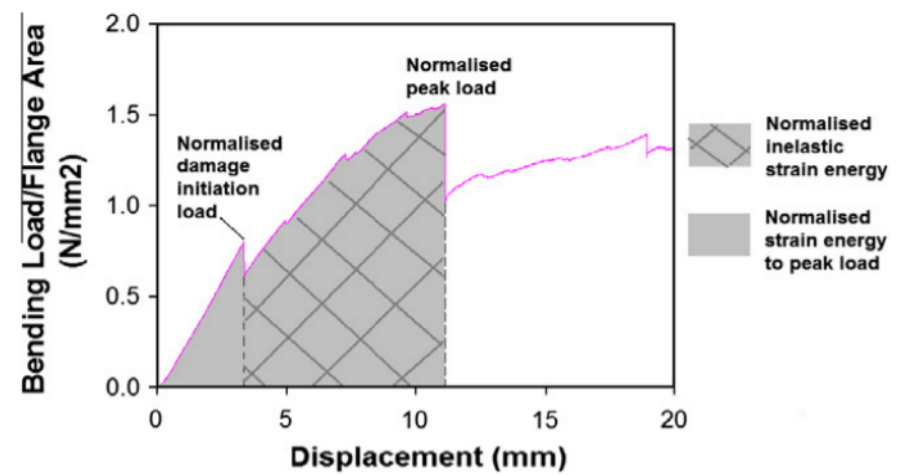
Figure 3. Definition of analysis metrics for T joint performance [25].